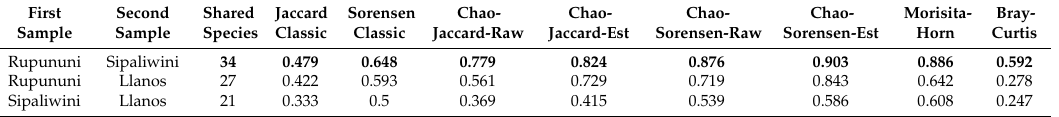
Table A2. Shared species between the savannas of the Rupununi of Guyana, Sipaliwini or Suriname, and Llanos of Venezuela. Highest values are in bold, which indicated that the Rupununi and Sipaliwini are more similar to each other than to the